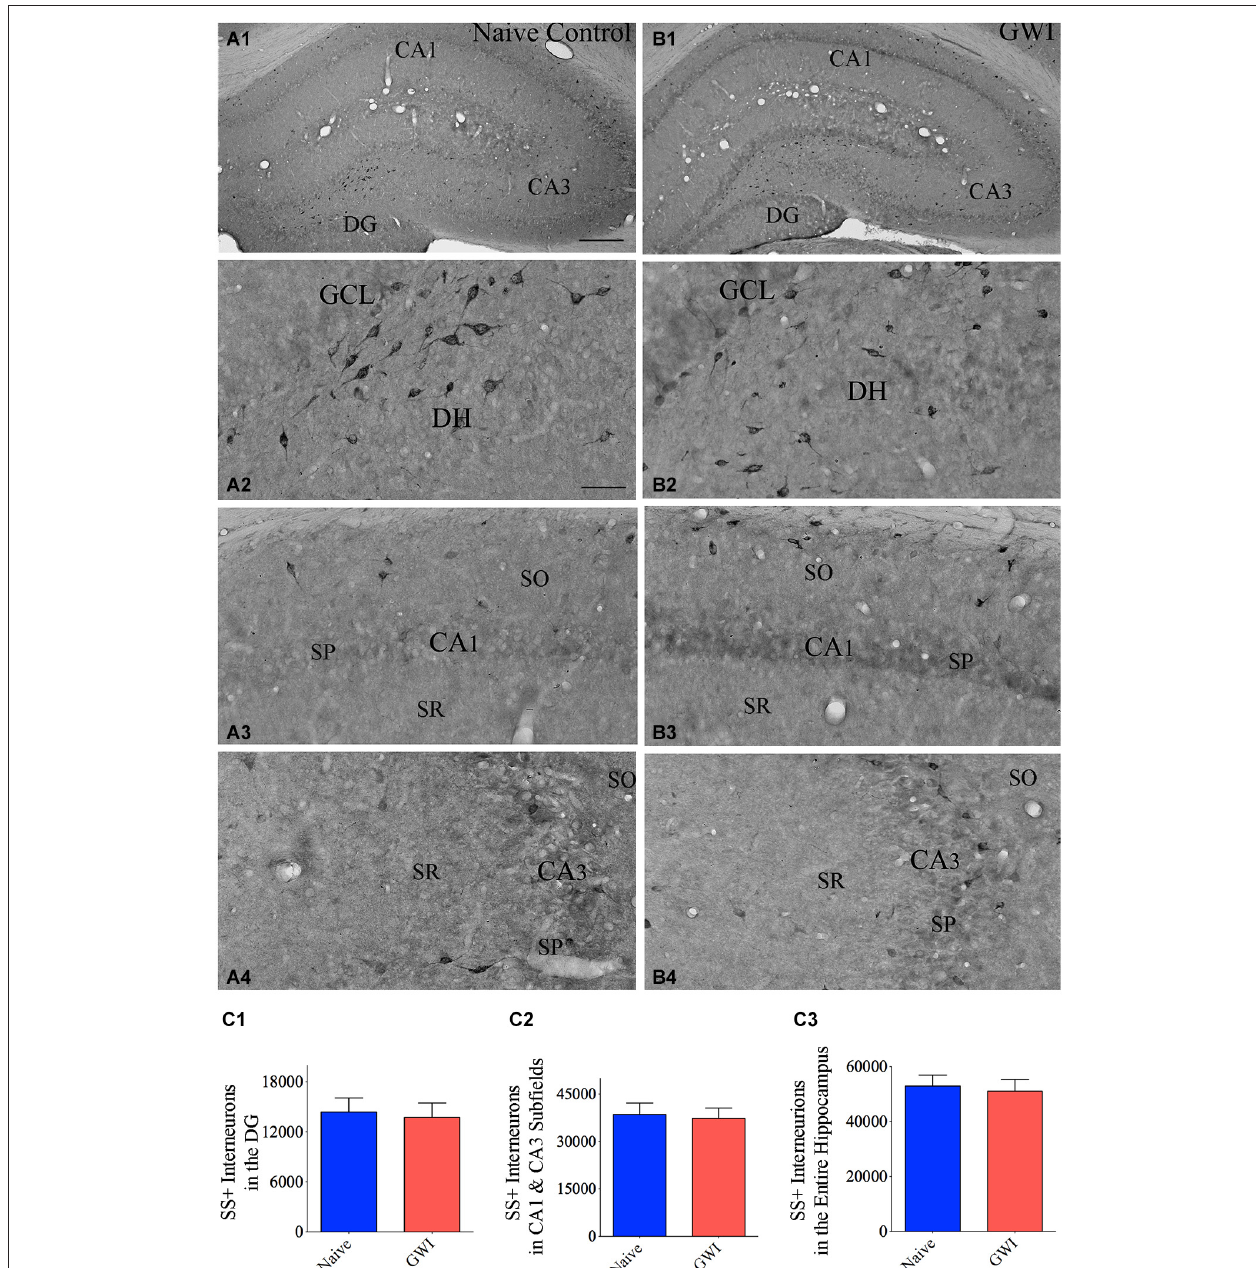
CA3 subfield from panel (B1) . Note that densities of SS+ interneuron cell bodies in all hippocampal regions appear comparable between a Gulf War illness (GWI)-rat (B2–B4) and a naive control rat (A2–A4) . Scale bar (A1) and (B1) = 500 µ m; (A2–A4) and (B2–B4) = 100 µ m. Bar charts in (C1–C3) compare numbers of SS+ interneurons in the DG (C1) , CA1 and CA3 subfields (C2) and the entire hippocampus (C3) between naive control rats and GWI-rats. DH, dentate hilus; GCL, granule cell layer; SO, stratum oriens, SP, stratum pyramidale; SR, stratum